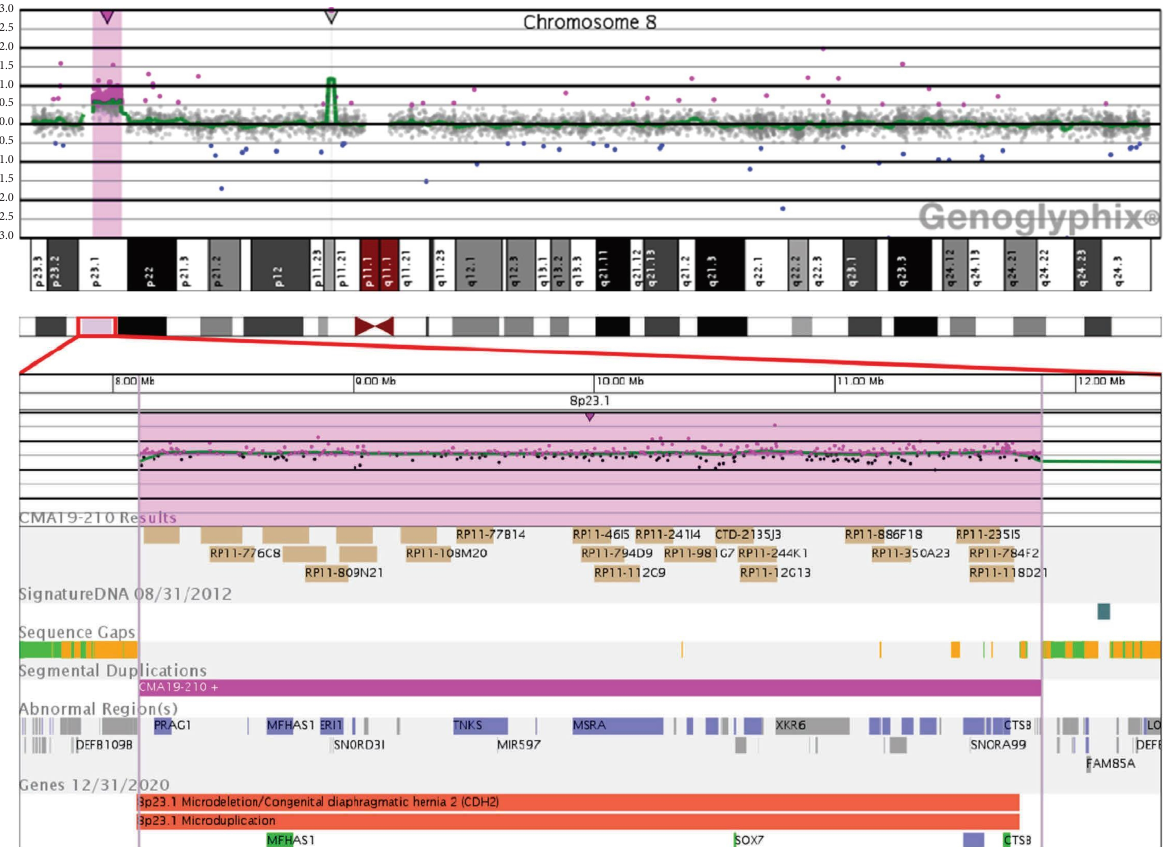
Figure 1: Analysis of 8p23.1 region. Te aCGH oligonucleotide data plot for chromosome 8 depicts a 3.75Mb microduplication (shaded in pink) of the 8p23.1 region including the SOX7